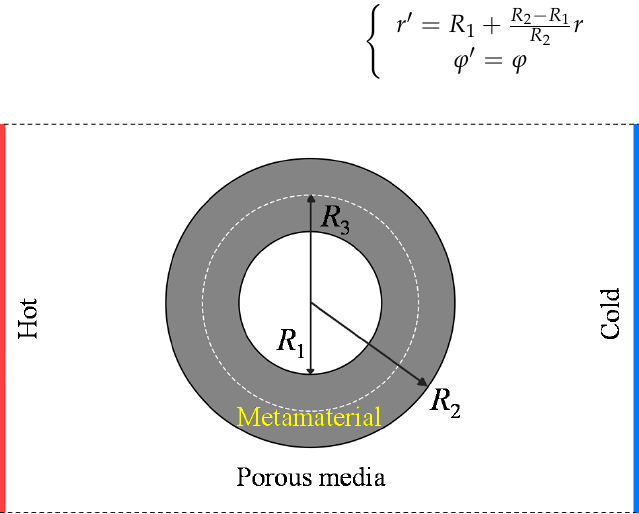
Figure 7. Schematic illustration of a convective thermal cloak.